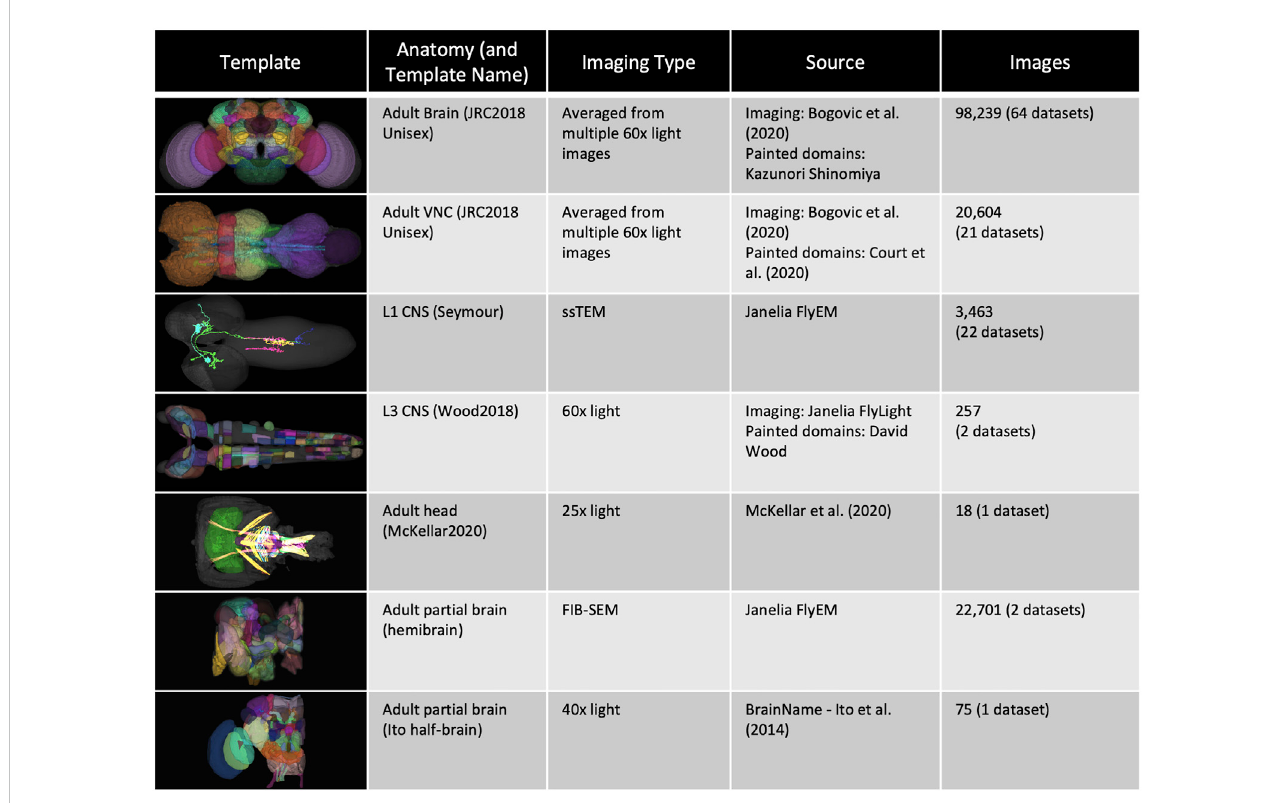
FIGURE 1 Templates and content . VFB has templates that integrate image data into common coordinate spaces and many more that serve as references for datasets in their native space The fi rst four rows of the table provide details of the most up-to-date integrative templates on VFB: the JRC2018 unisex adult braintemplate(Bogovicetal.,2019)hasthelargestnumberofalignedimages,whichincludeover26,500EMimagesfromCATMAIDFAFB(Zhengetal.,2018) and the Janelia Hemibrain (Scheffer et al., 2020) combined, over 70,000 images showing expression patterns or fragments of expression patterns from sources including FlyCircuit (Chiang et al., 2010; Shih et al., 2015) and Janelia FlyLight (Meissner et al., 2022) and 46 painted neuropil domains (painted by Kazunori Shinomiya); The JRC2018 adult ventral nerve cord (VNC) template (Bogovic et al., 2019) has over 2,000 EM images from CATMAID FANC (Phelps et al., 2021), over 18,000 images of expression patterns from sources including FlyLight and 21 painted domains (Court et al., 2020)The Seymour L1 template has nearly 3,500 EMimagesfrom CATMAID L1(Ohyama et al., 2015); The Wood2018 template has 255painted domains (David Woodand Volker Hartenstein, unpublished). The rest of the table provides details of three of the available reference templated on VFB: the McKellar2020 adult head template has